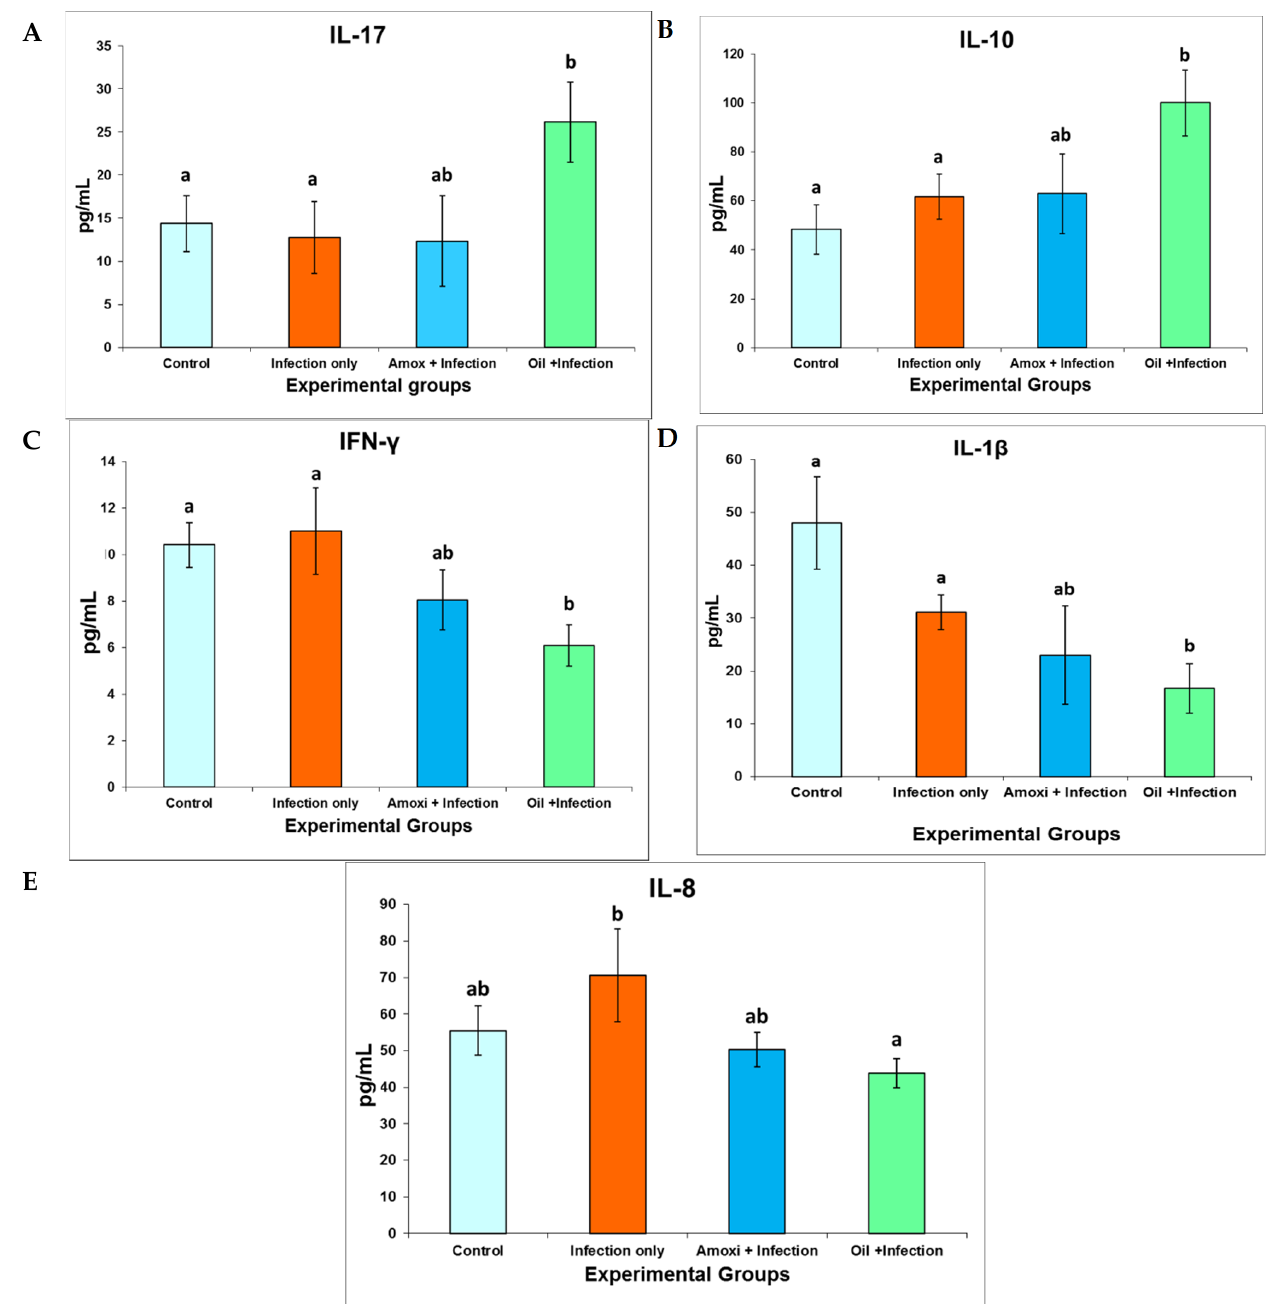
Figure 3. The concentrations of the IL-17 ( A ), IL-10 ( B ), IFN- γ ( C ), IL-1 β ( D ), and IL-8 ( E ) cytokines in comparison with the challenge experimental NE study obtained through ELISA. At 19 days of age, the chickens were infected for 4 continuous days through oral administration of broth cultures of C. perfringens . On the second day of C. perfringens infection, the chicks were orally administrated the recommended dose of the coccidial vaccine 10 times. The treatment was administrated in drinking water on day 22 and continued for 5 days. Sera were collected at day 27 postchallenge. The values are means ± S.E. Different letters represent statistically significant differences with a p -value less than 0.05.